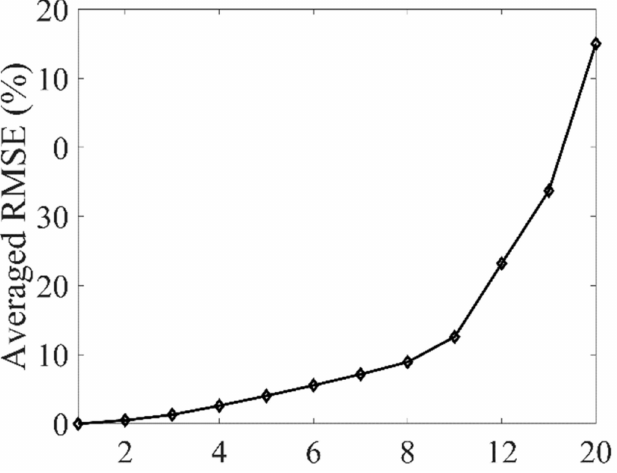
Figure 10. The averaged RMSE of different up-sampling